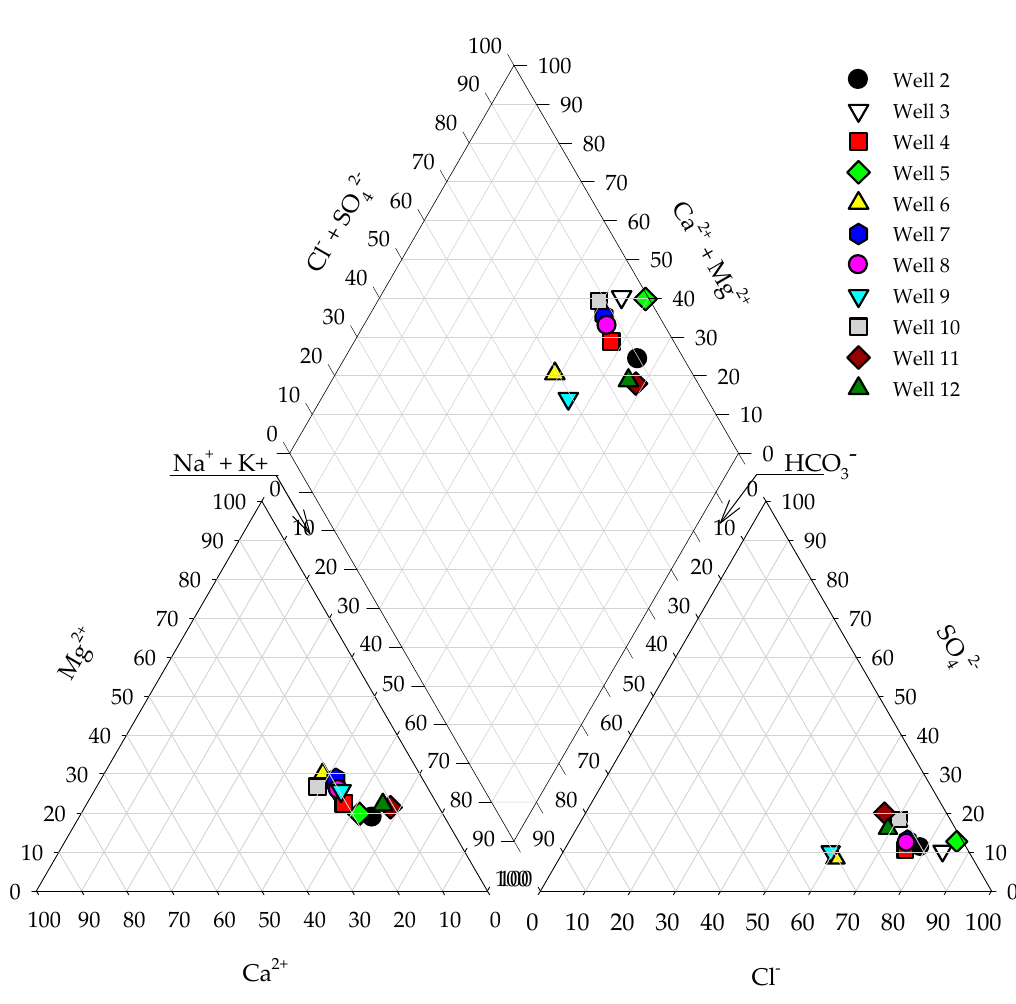
Figure 5. Piper diagram for the wells with Type II water.